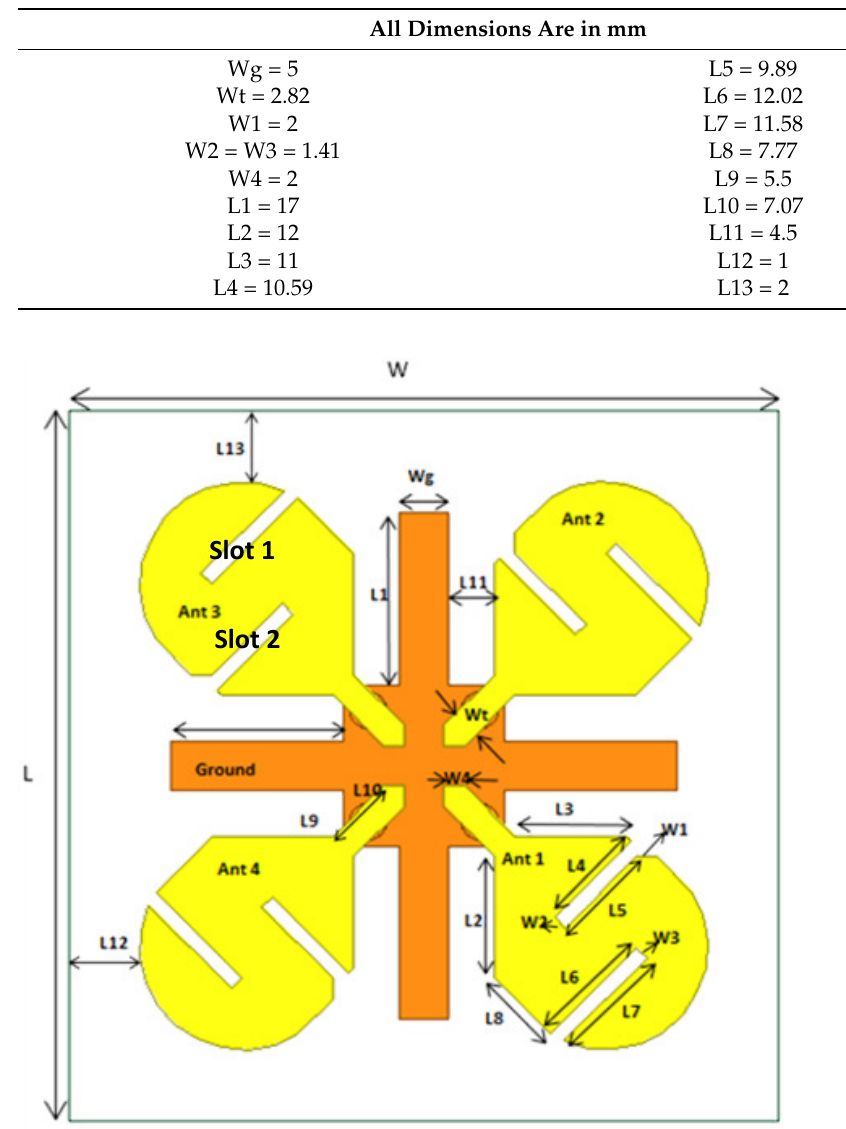
Figure 1. Geometry of the four-element MIMO antenna